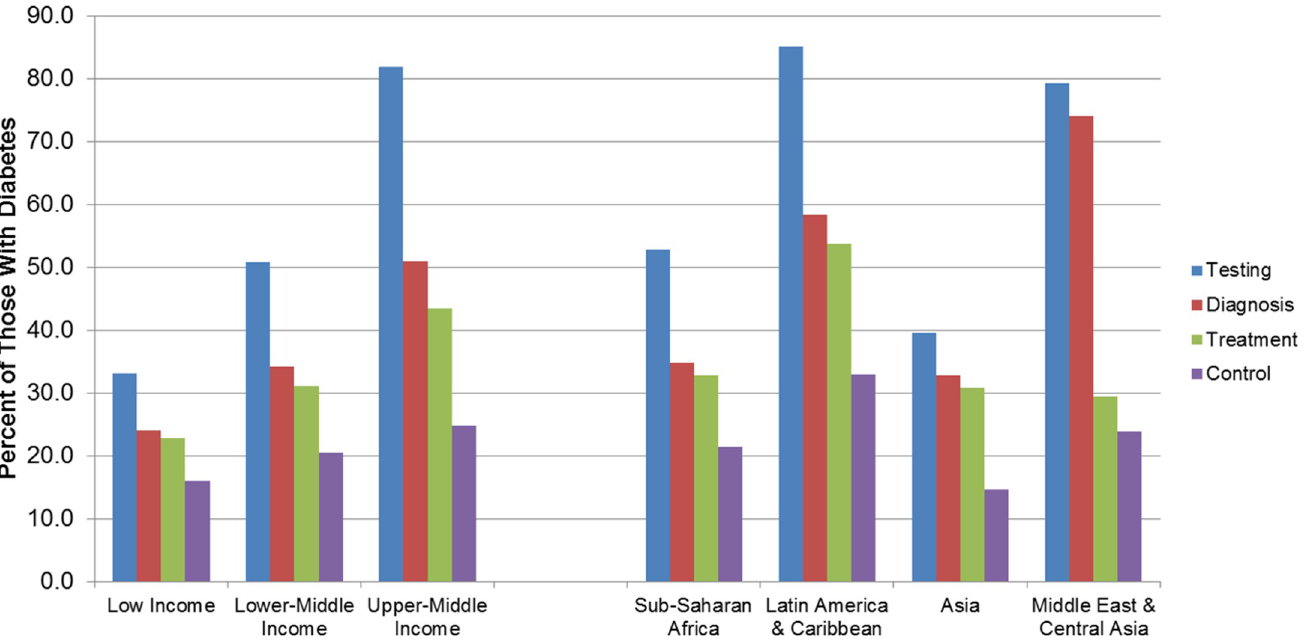
Fig 2. The diabetes cascade of care by world bank income group and geographic region in population-based surveys conducted in 28 low- and middle-income countries between 2008 and 2016. “Asia” is South and Southeast Asia.